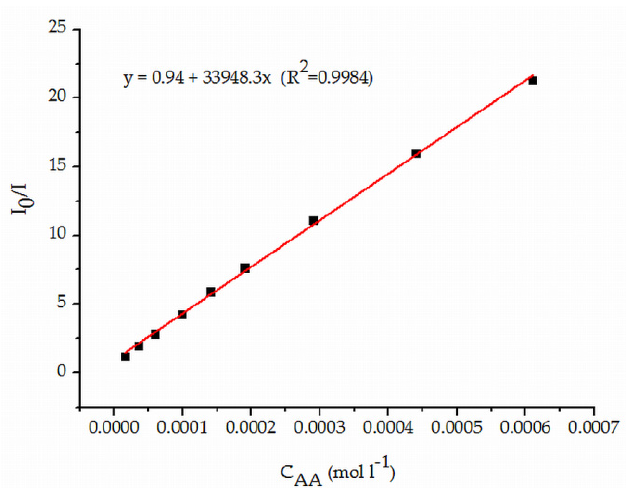
Figure 7. Stern–Volmer plot for Tb(Phen) quenching by ascorbic acid.